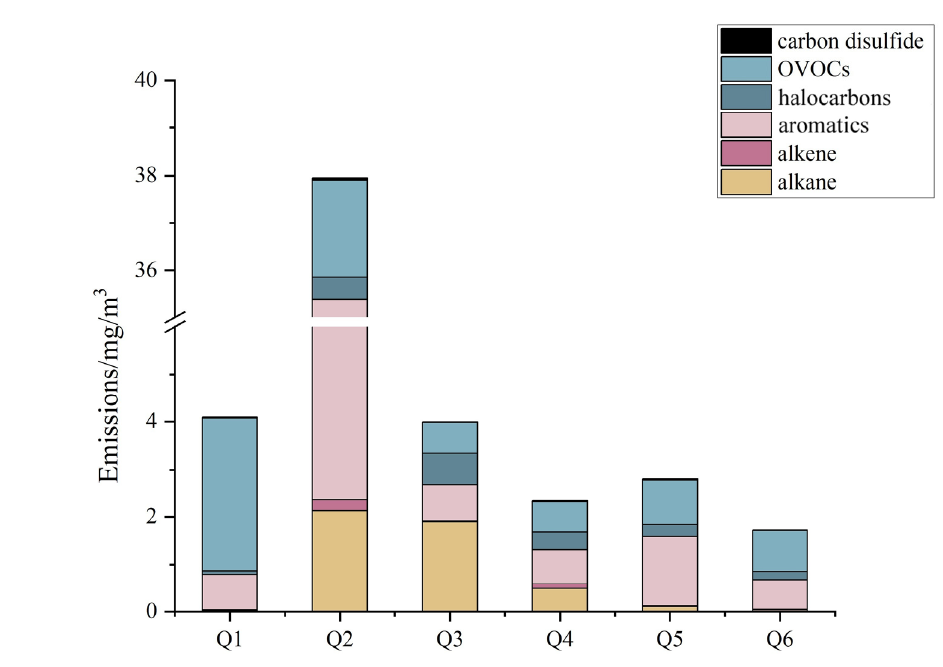
Figure 2. Characteristics of species concentration of six glass deep ‐ processing enterprises.